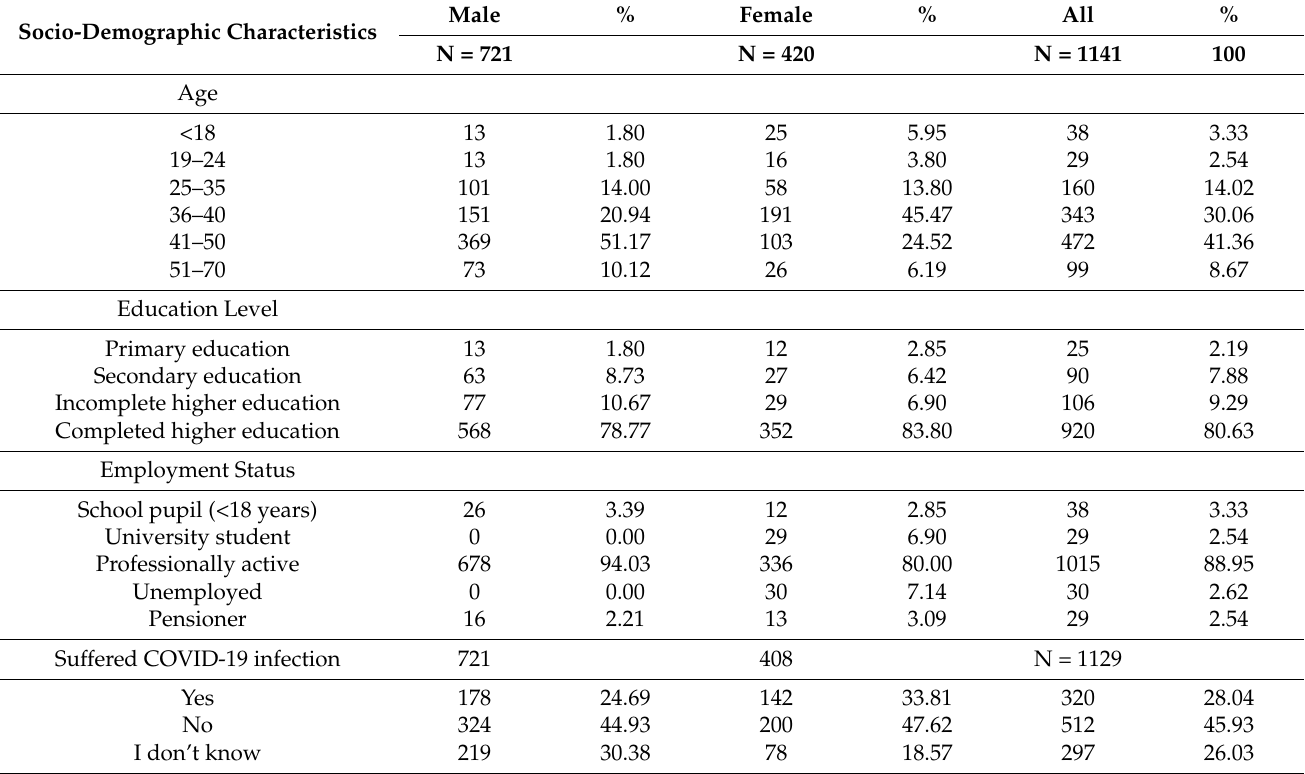
Table 1. Socio-demographic characteristics of